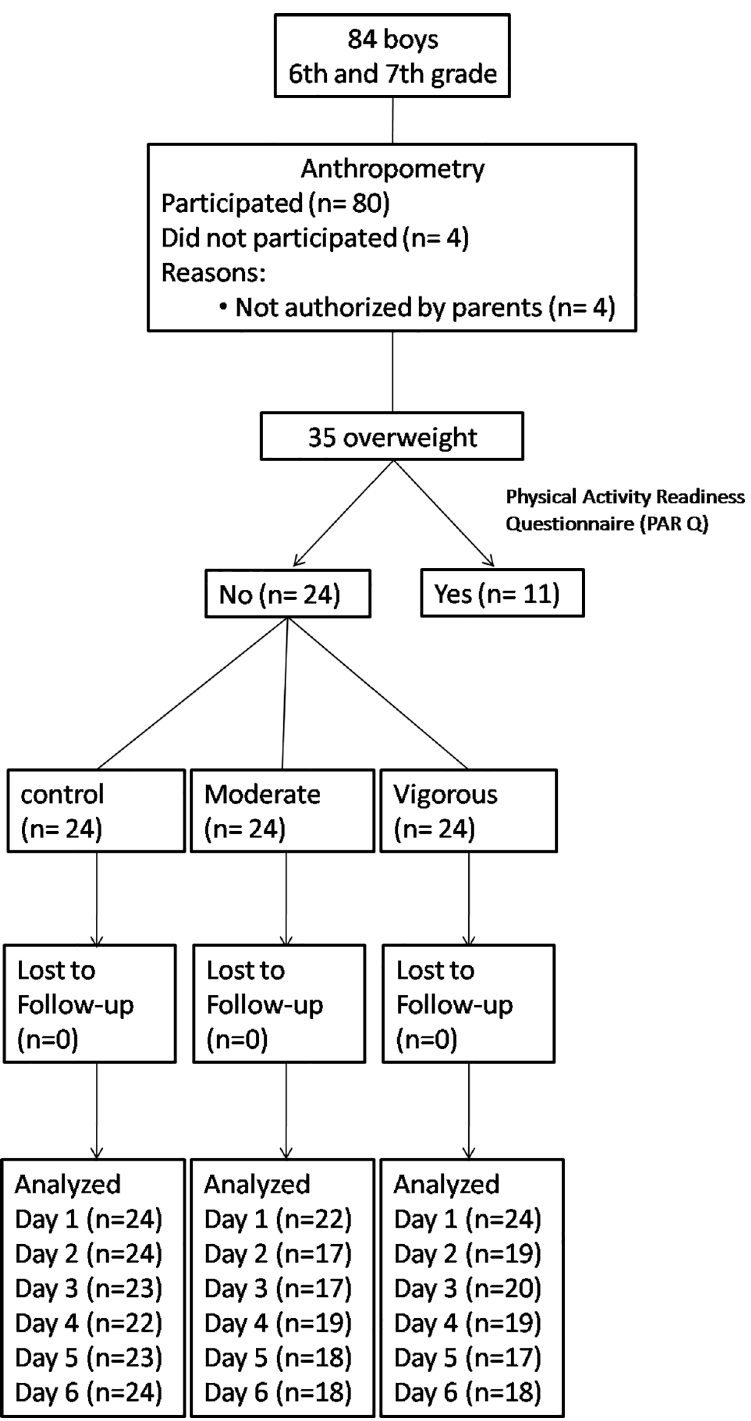
Fig 1. Flow diagram of participants through the